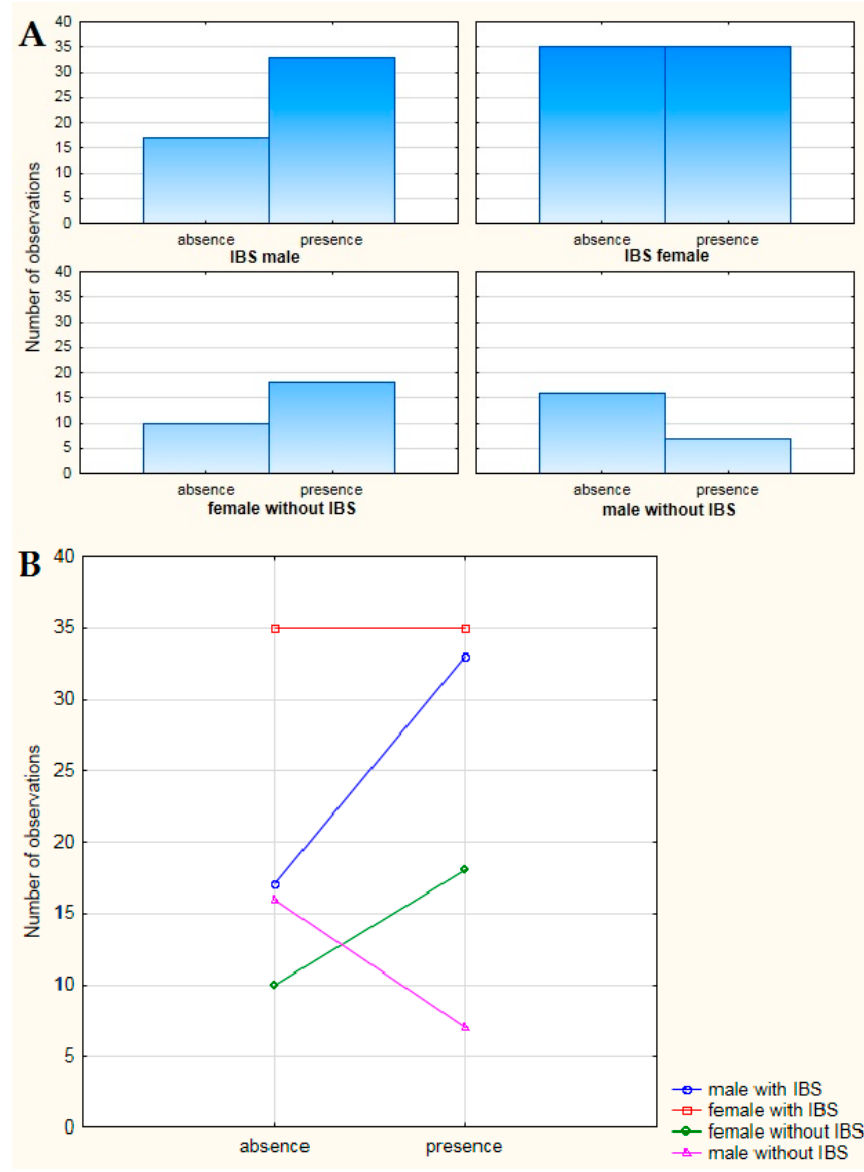
Figure 2. ( A ) Histograms representing an occurrence of the RHOM_14635 gene fragment among the studied groups. ( B ) Interaction plot shows the difference between the frequencies of the RHOM_14635 gene fragment occurrence in the studied groups. The interaction is seen between females without IBS and males with